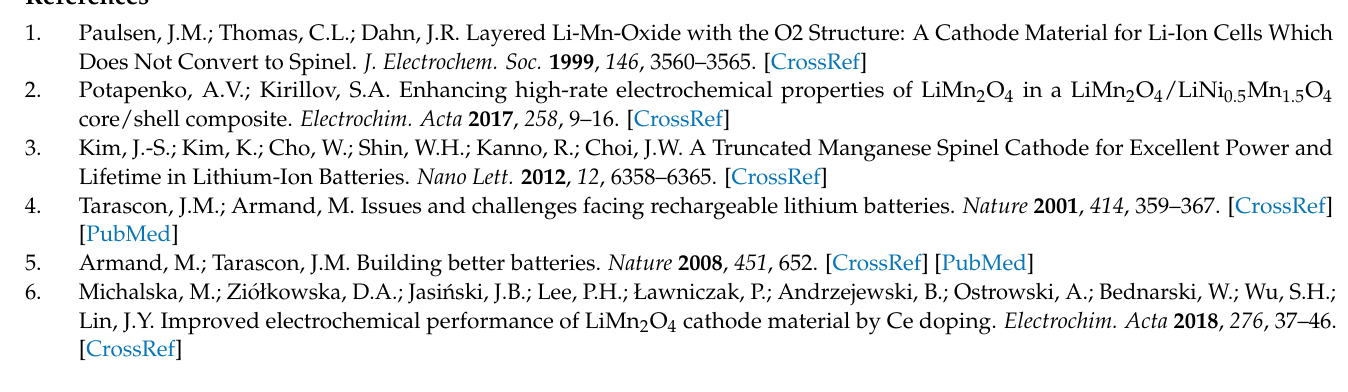
LMO-B samples; Table S2: Comparison of electrochemical performance of different LiMn 2 O 4 electrode